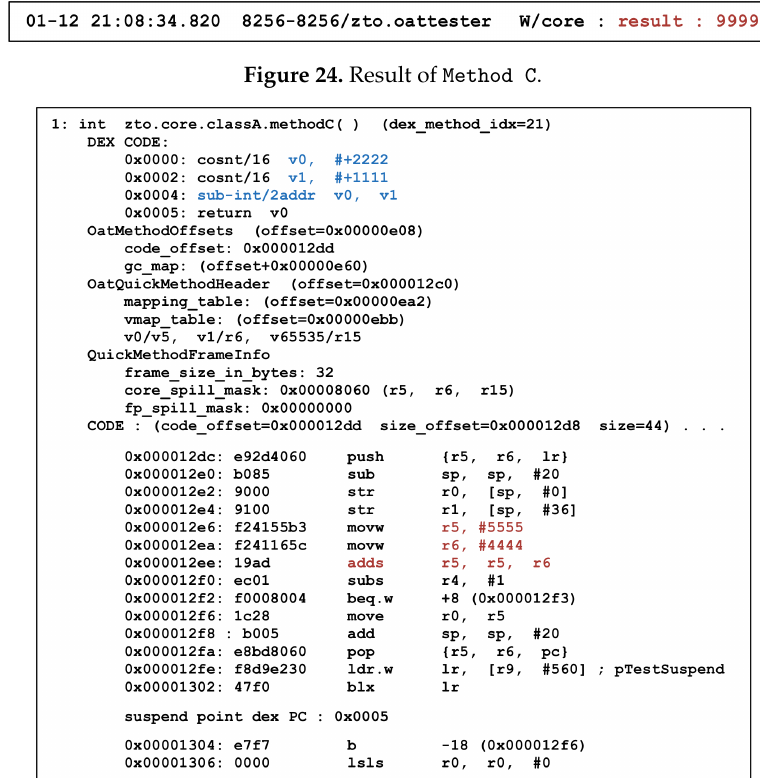
Figure 24. Result of Method C .